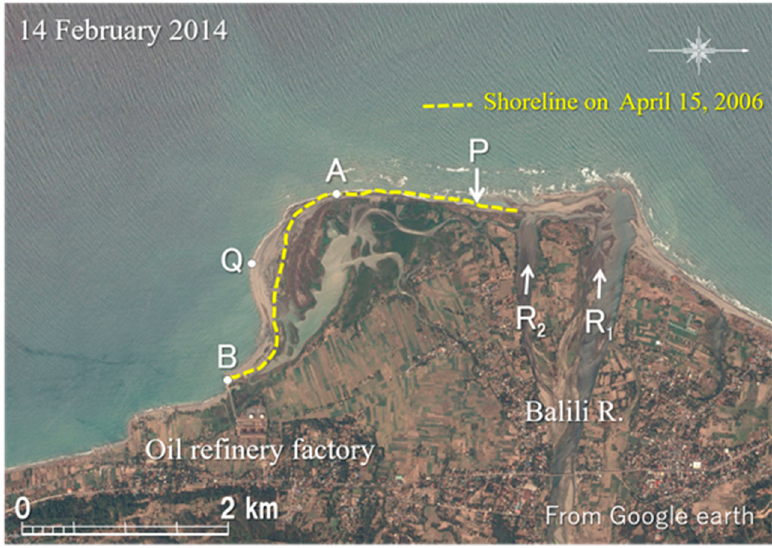
Figure 4. Satellite image of shoreline around Balili River mouth (14 February 2014).